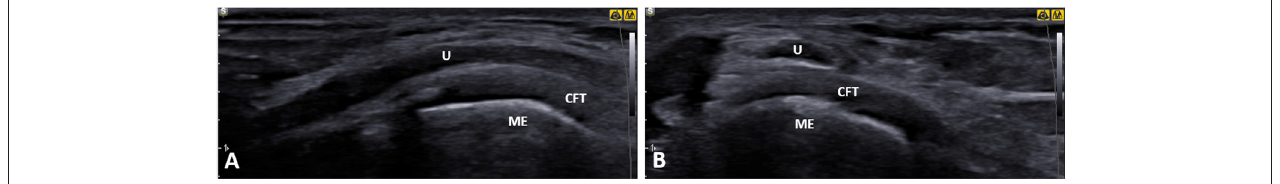
FIGURE 5 | Ultrasound ( US ) imaging of the ulnar nerve ( U ) at the level of the medial epicondyle ( ME ) in a patient with symptomatic ulnar nerve dislocation. Both longitudinal (A) and short-axis (B) views clearly demonstrate a close contact between the ulnar nerve and common flexor tendon origin. U, ulnar nerve; CFT, common flexor tendon; ME, medial